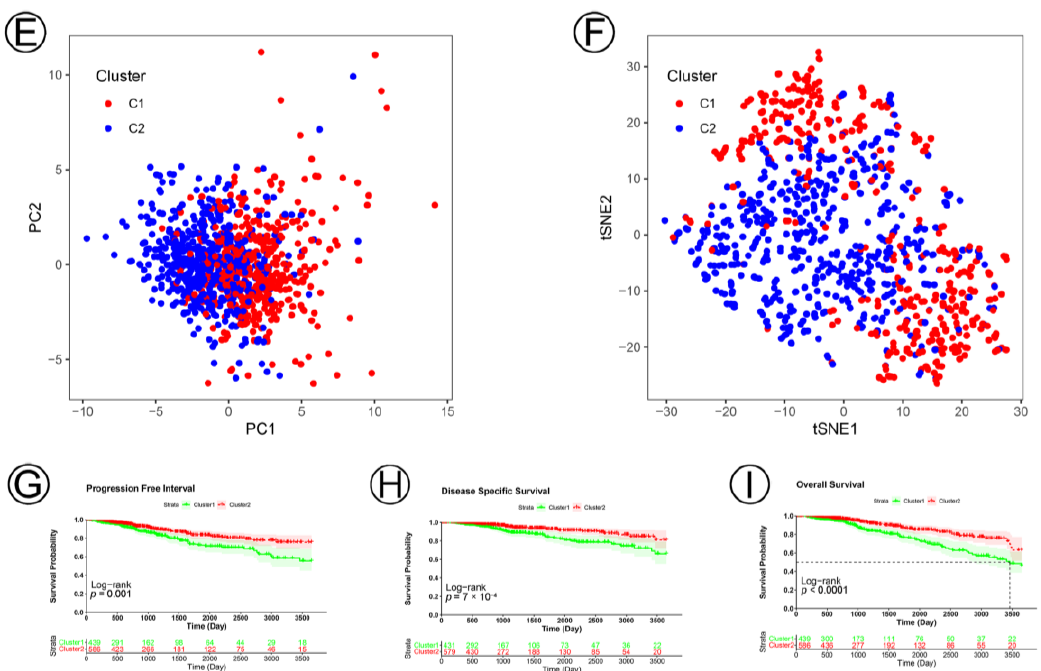
Figure 1. Pyroptosis-related clusters were determined according to 38 pyroptosis-related genes in BC. ( A ) A heatmap of the expression levels of 38 pyroptosis-related genes between the normal and tumor tissues. ( B , C ) Consensus clustering CDF and relative change in area under CDF curve for k = 2–9. ( D ) Consensus cluster matrix of breast cancer tumor samples when k = 2. ( E , F ) Two-dimensional principal component, and viSNE analysis based on the expression levels of 38 pyroptosis-related genes. The red dots represent C1, and the blue dots represent C2. ( G – I ) KM curves of PFI, DSS, and OS for the two pyroptosis-related clusters. Notes: * , p < 0.05 ; ** , p < 0.01; *** , p < 0.001.